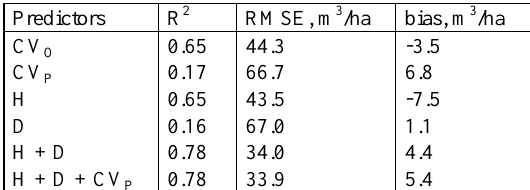
Table 1. Accuracies of predicting the plot-level stem volume with Eq. 2 fit with the given predictors. CV O – the tetrahedral volume of the optimized filtrations, CV P – the tetrahedral volume derived by persistent homology, H – the most correlated height feature (90th percentile), D – the most correlated density feature (proportion of echoes above 1 m height). The average stem volume was 197.6 m 3